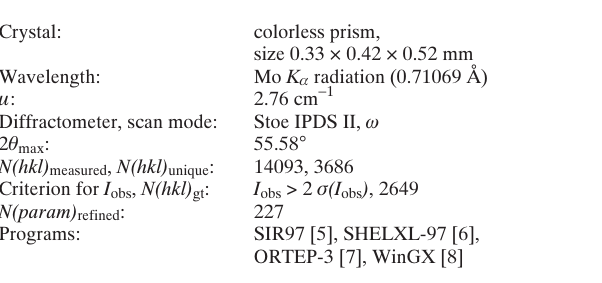
Table 1. Datacollection and handling.